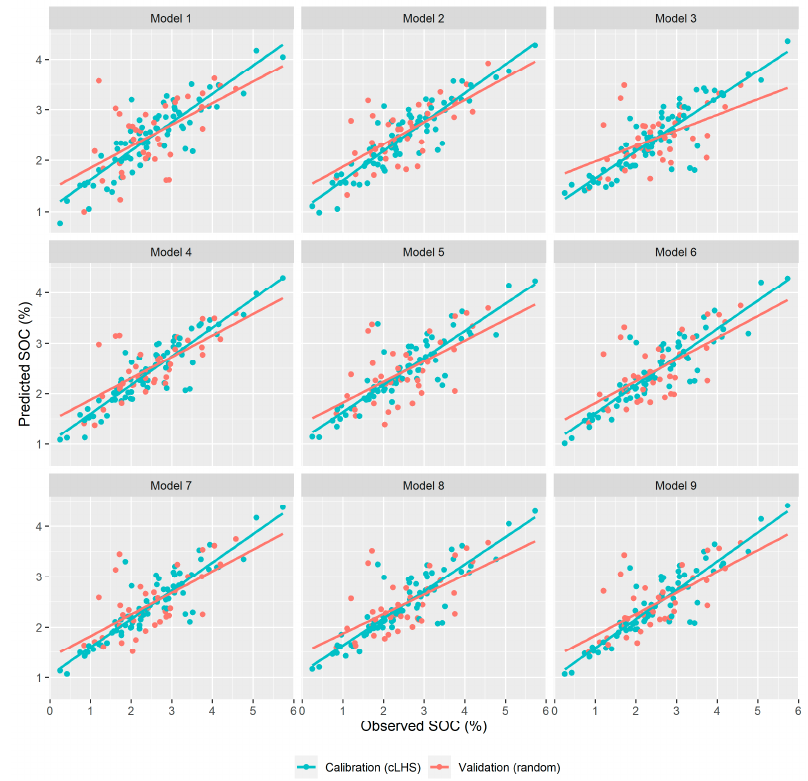
Figure 4. Observed and predicted SOC contents for the 9 models.